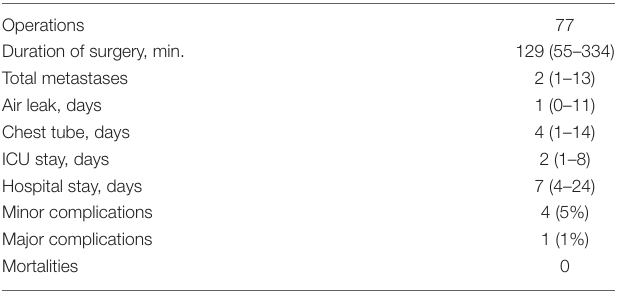
TABLE 1 | Surgical parameters. Operations